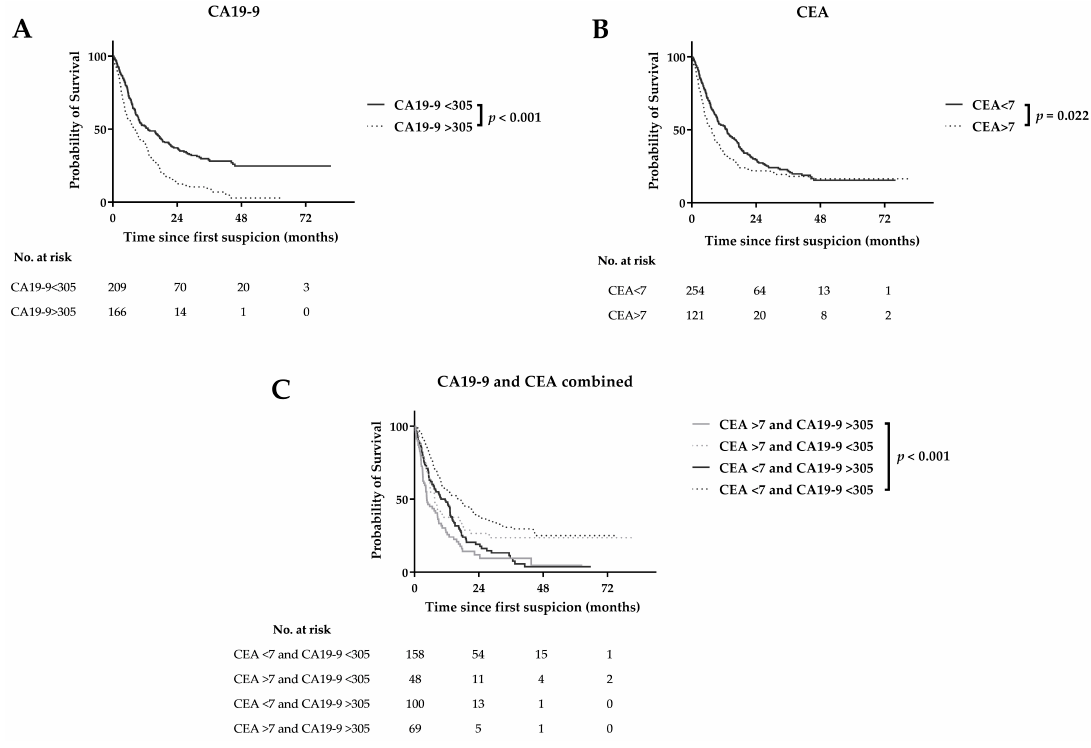
Figure 1. Survival curves for CA19-9 ( A ) CEA ( B ) and combined CA19-9 and CEA ( C ) serum levels. At multivariate analysis, ASA score III-IV (HR: 1.74 (1.15–2.66)), CA19-9 > 305 kU / L (HR: 1.72 (1.31–2.26)) and tumor size > 20 mm (HR: 2.36 (1.49–3.73)) were prognostic factors for